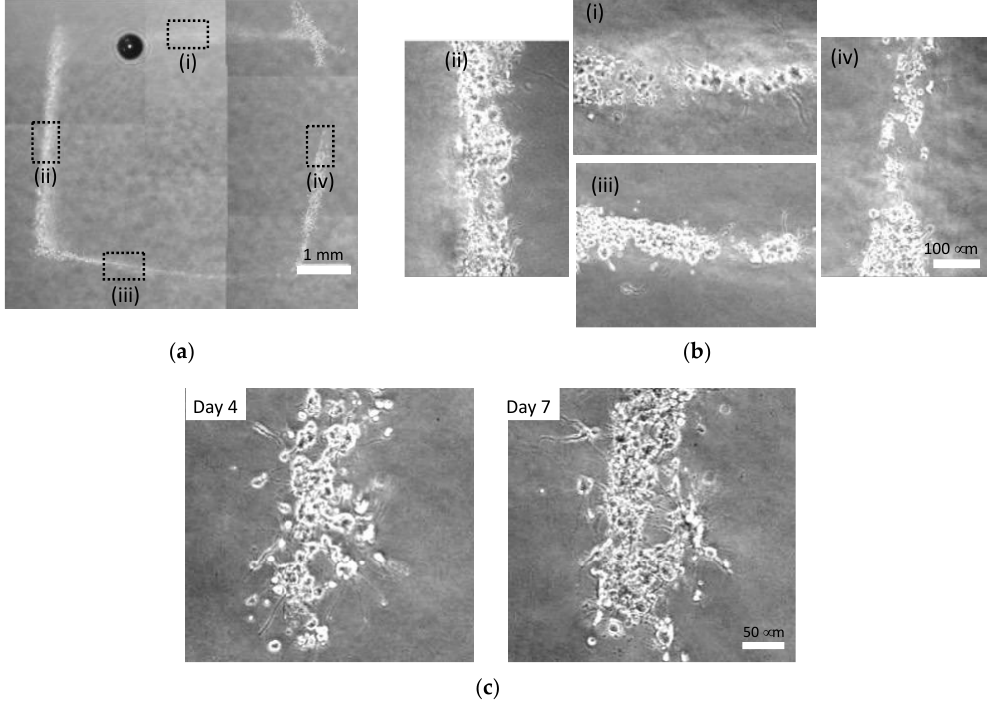
Figure 10. Phase-contrast images of square pattern of PC-12 cells injected at 0.196 mL/s in atelocollagen gel. ( a ) Gross image, ( b ) enlarged images of (i) Line 1, (ii) Line 2, (iii) Line 3 and (iv) Line4 of square pattern on day 7; ( c ) Neurite growth during the culture time.